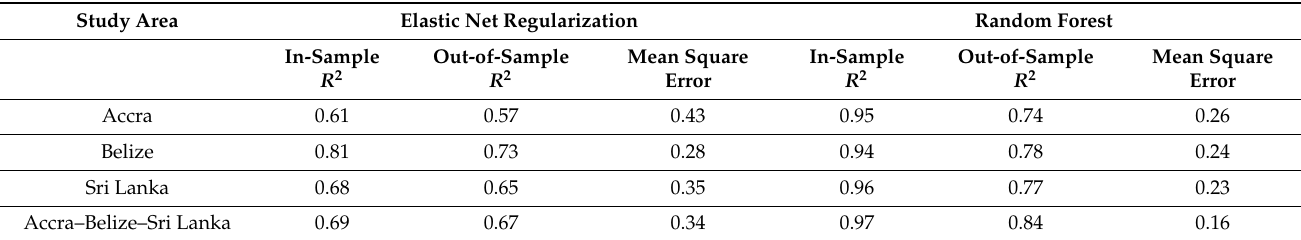
Table 12. R 2 and mean square error values for population density using elastic net regularization and random forest models with Sentinel-2 imagery for Accra (2216 Enumeration Areas), Belize (687 Enumeration Districts), and Sri Lanka (13,402 Grama Niladhari